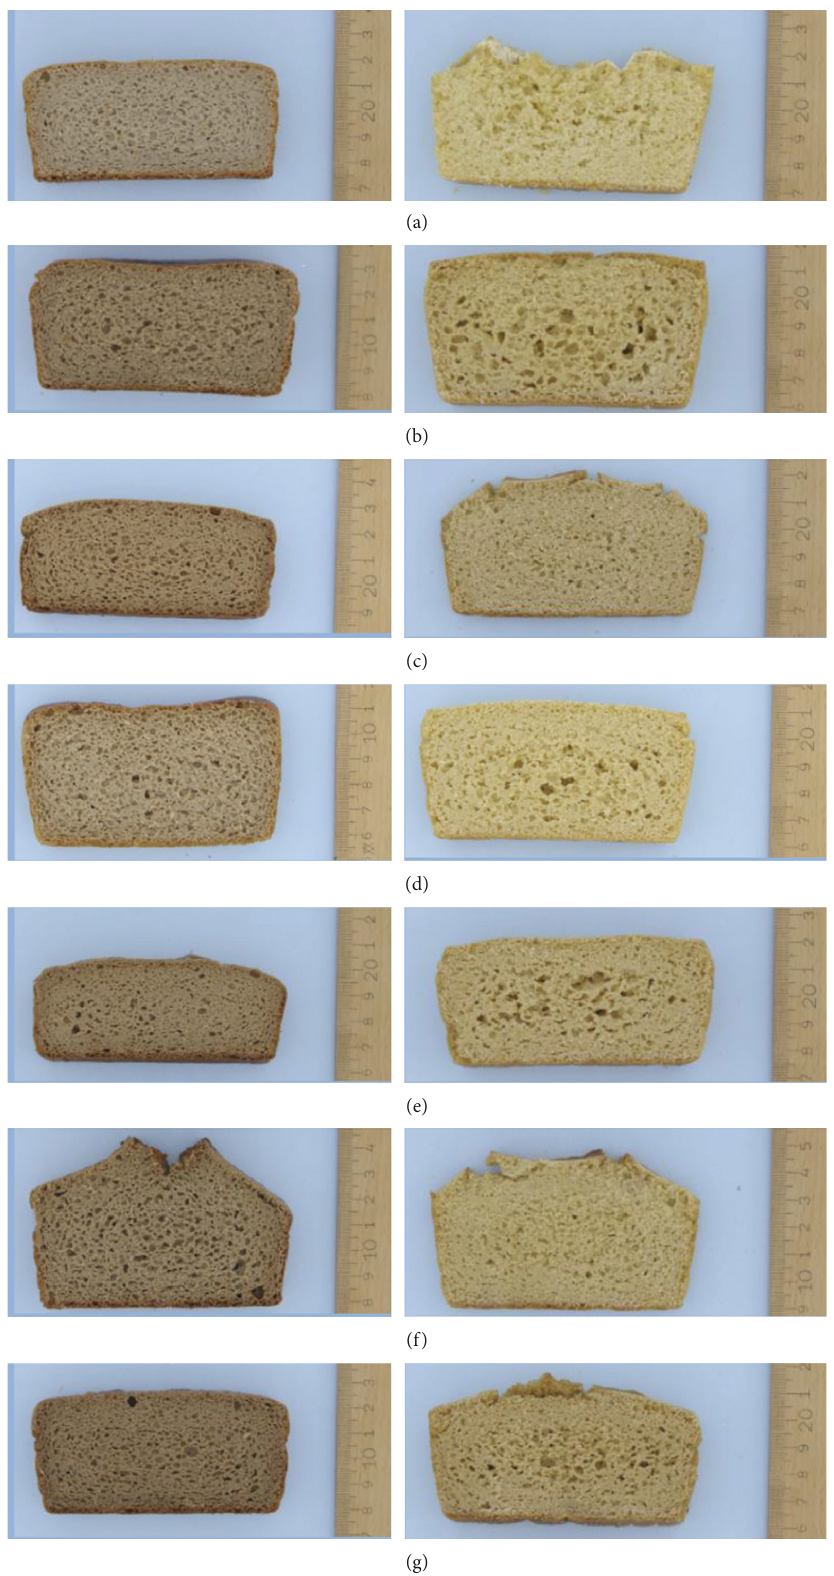
Figure 3: Slices of sourdough-bread made from whole meal buckwheat (left) and millet (right) flour added with differently extracted arabinoxylans. (a) Control. (b) WEAX. (c) NEAX. (d) CEAX. (e) PEAX. (f) WPEAX. (g)